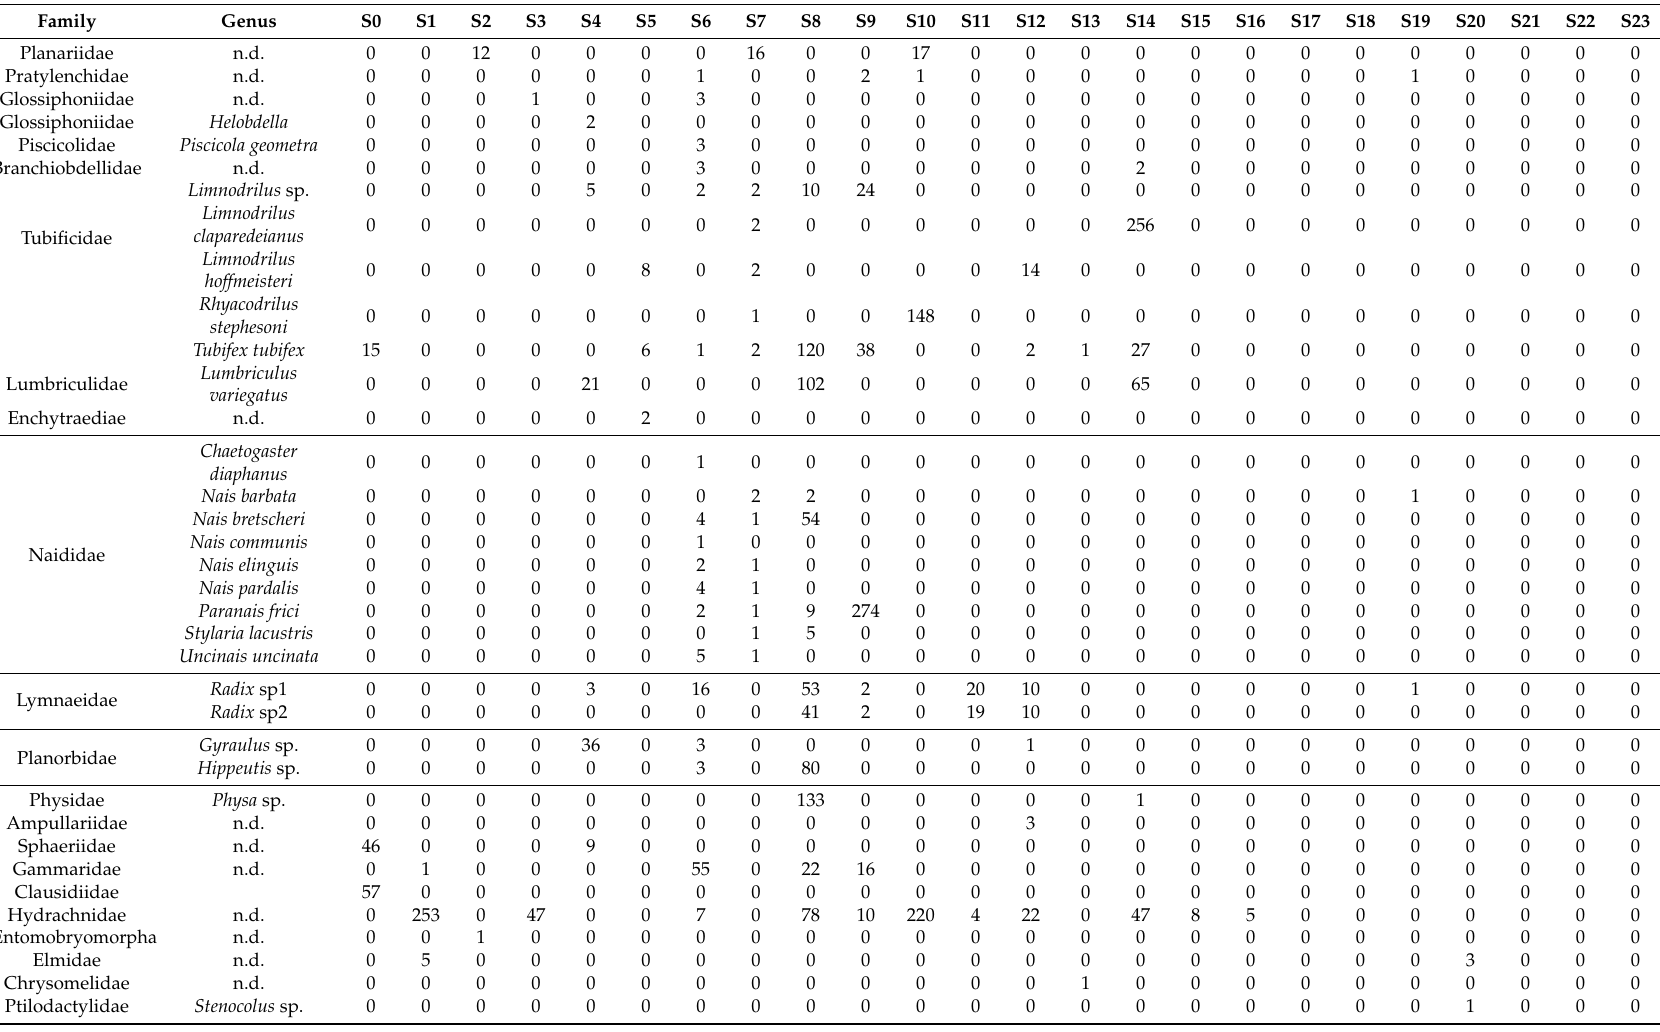
Table 8. Taxa and density compositions of macroinvertebrates in the sampling sites of Yalutsangpo basin (numbers indicate density, ind./m 2